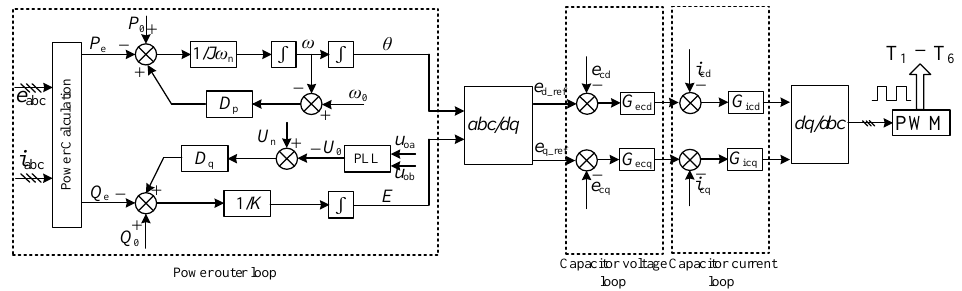
Figure 2. Control loop diagram of a VSG grid-connected inverter system.